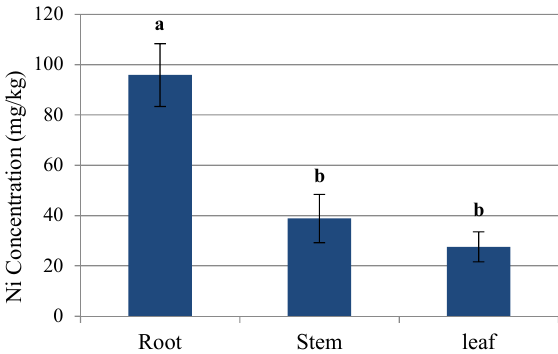
Fig. 5. Mean Ni Concentration in Treatment of 200